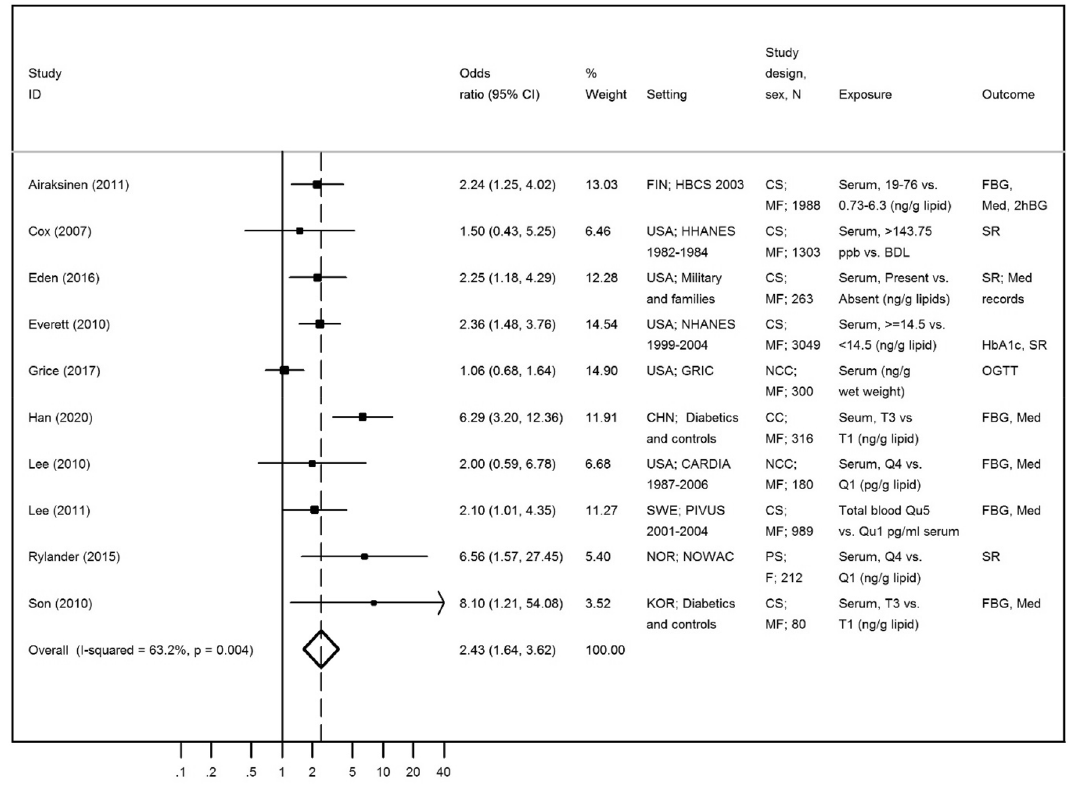
Figure 5. Meta-analysis of studies evaluating the association of trans-nonachlor with diabetes-related features in adults. Odds ratios and corresponding 95% CI (horizontal lines). The size of the black square indicates the study’s weight in the analysis (weights are from fixed-effects analysis). The centre of the open diamond indicates the summary estimate and its width represents the 95%